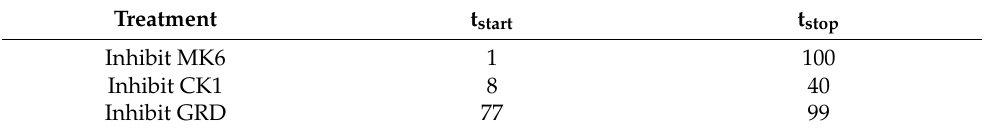
Table 3. The three intervention treatments course starting from SS4 results in a 61% return to health. Treatment